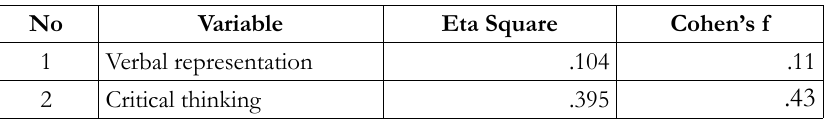
Table 8. Result of effect size